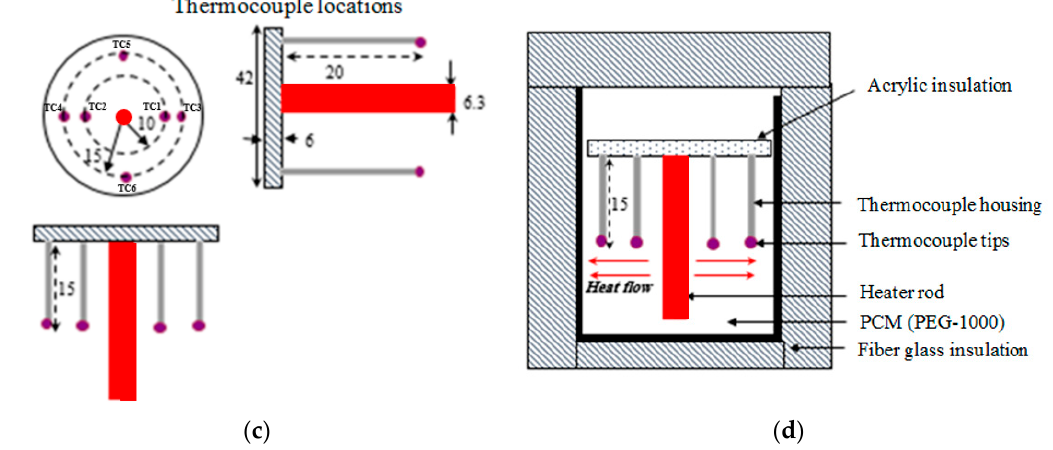
Figure 5. Cylindrical configuration test set-up for measurement of PCM thermal conductivity and melting test. ( a ) Heating and temperature measurement arrangement; ( b ) Actual test set-up; ( c ) Thermocouple locations; ( d ) Cross section of test set-up detailing different components and heat flow pattern.